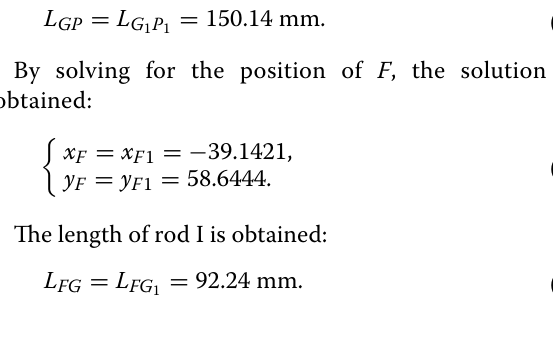
= 92.24 mm. L FG = L FG 1